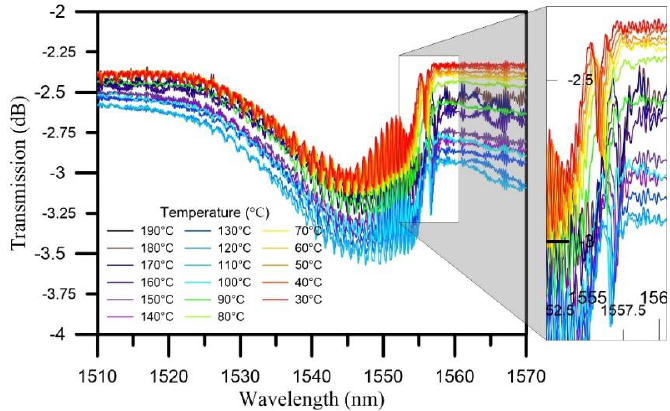
Figure 8. The transmission spectrum of the TFBG sensor during the heating stage.